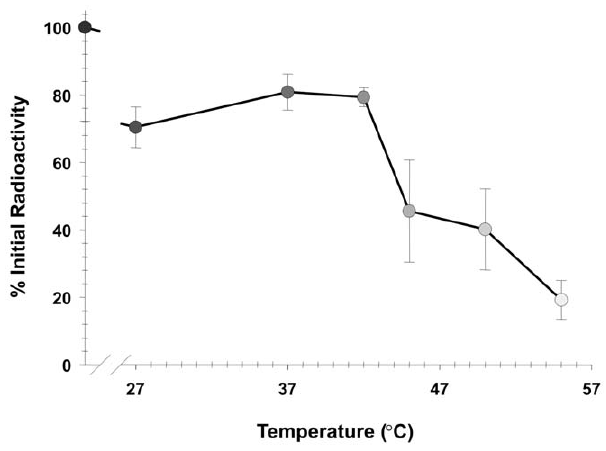
Figure 6. Comparison of 99m Tc radiolabel stability on Ad-tGFP- pIX-MT. After 30 min incubation with 50% normal mouse serum at increasing temperatures, samples were analyzed by HPLC on a Bio- Monolith column for 99m Tc-radiolabeled Ad-tGFP-pIX-MT in each sample. Radioactivity of peaks corresponding to Ad-tGFP-pIX-MT were quantified and normalized to the radio activity of peaks corresponding to Ad-tGFP-pIX-MT after 30 min in the absence of serum at 27 u C. Each point represents the mean 6 SE of three replicate